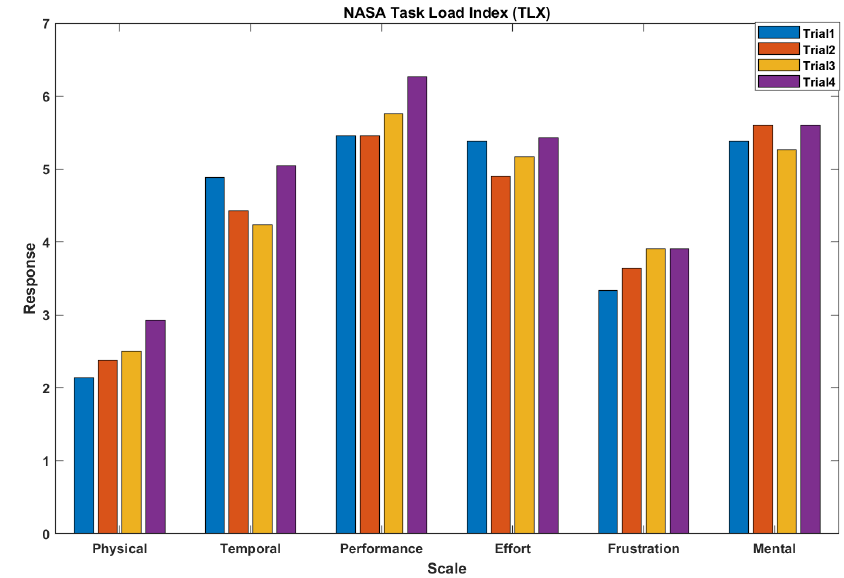
Figure 2. Average task load index experienced by participants in trial